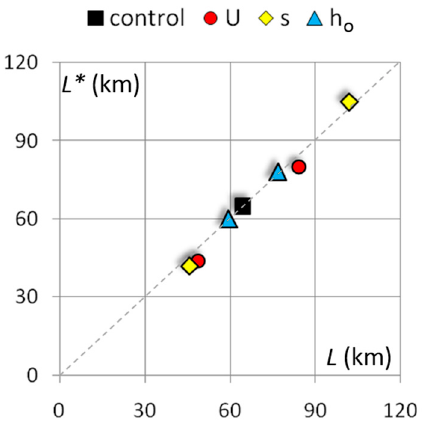
Figure 13. Canyon-upwelling scenario. Comparison between theoretical ( L ) and simulated wavelengths ( L *) of pressure anomalies developing on the continental shelf in the lee of the shelf-break canyon.